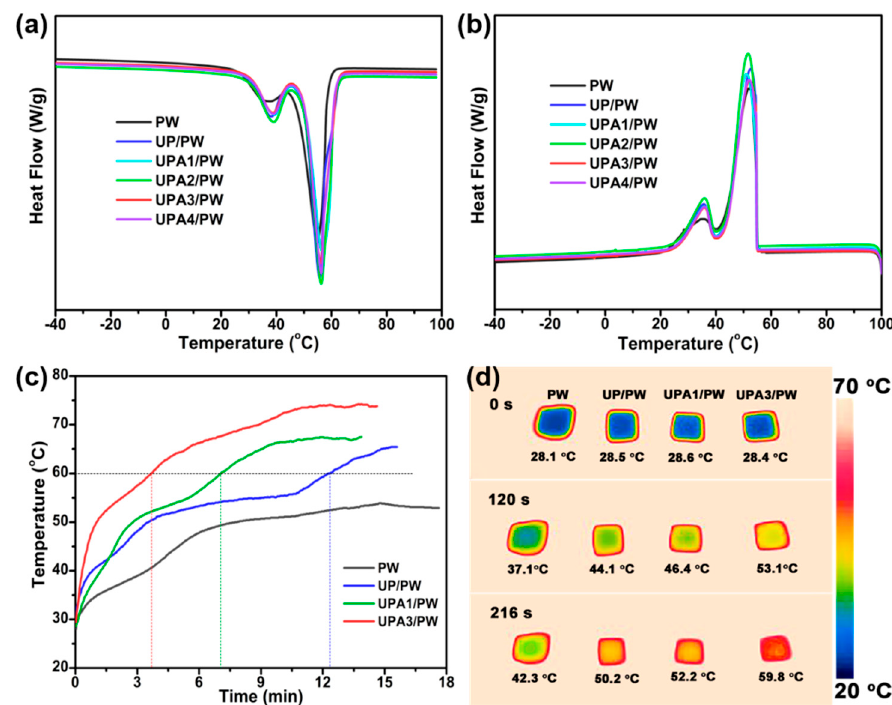
Figure 3. Thermal properties of PCCs. The DSC ( a ) heating and ( b ) cooling curves of PW and PCCs; ( c ) Temperature–time curves and ( d ) Infrared thermal images of PW, UP/PW, UPA1/PW and UPA3/PW during the charging process.